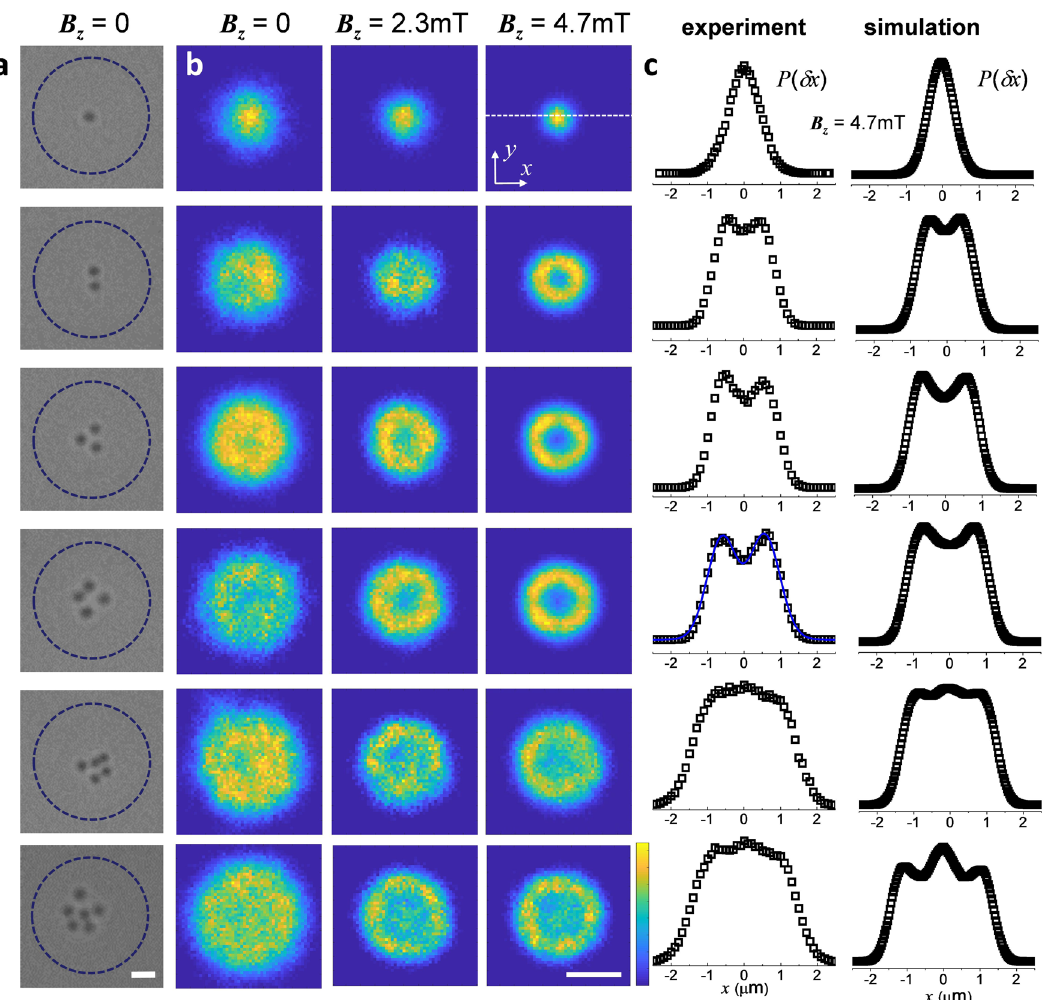
Fig. 4 Stationary collective states in the magnetic trap. a Sequence of optical microscope images showing different con fi ned nanoparticles (from top to bottom) for B z = 0 mT. The superimposed dashed line indicates the location of the Bloch wall, scale bar is 2 μ m. b Two-dimensional density distribution of the particle positions projected onto the ( x , y ) plane. High (low) probabilities correspond to yellow (blue) regions. Scale bar at the bottom is 2 μ m. c Probability distributions P ( δ x ) of the particle displacement along the x -axis from experiments (left column) and numerical simulation (right visible narrowing of the potential well: notice not only the right part of the graphs in Fig. 3b, but also steeper repulsion tails with the growth in B z , as can be observed from the left part of the graphs. Fitting the simulation data to the experiment for U ( r ) fi xes the fi eld-dependent strength γ ( B z ) of the pairwise repulsive interactions, U 2 ( r ).